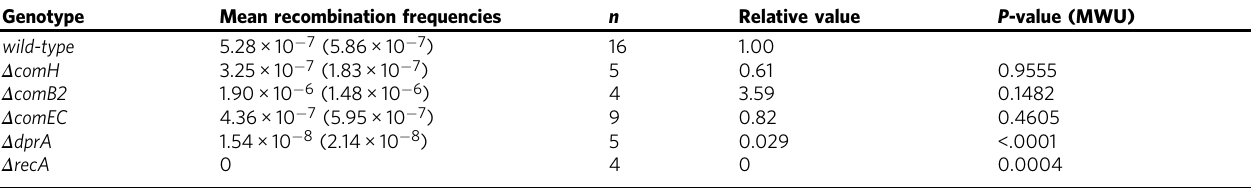
Table 2 Transformation frequencies determined for electroporated H. pylori strains.